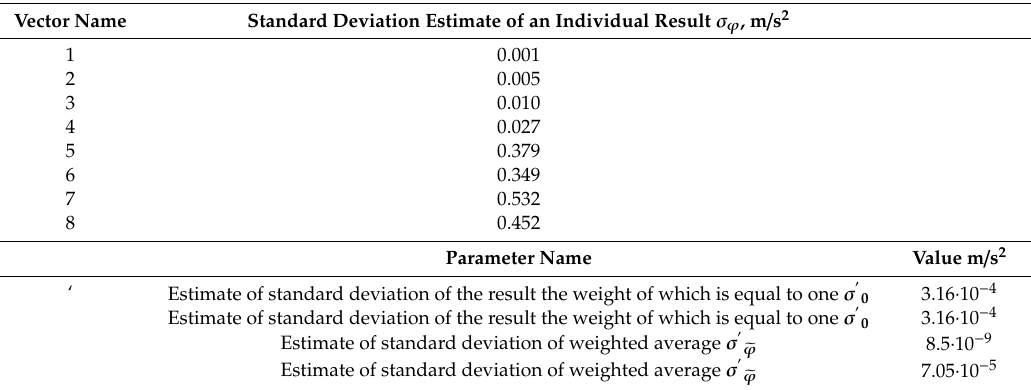
Table 2. Precision indicators of acceleration